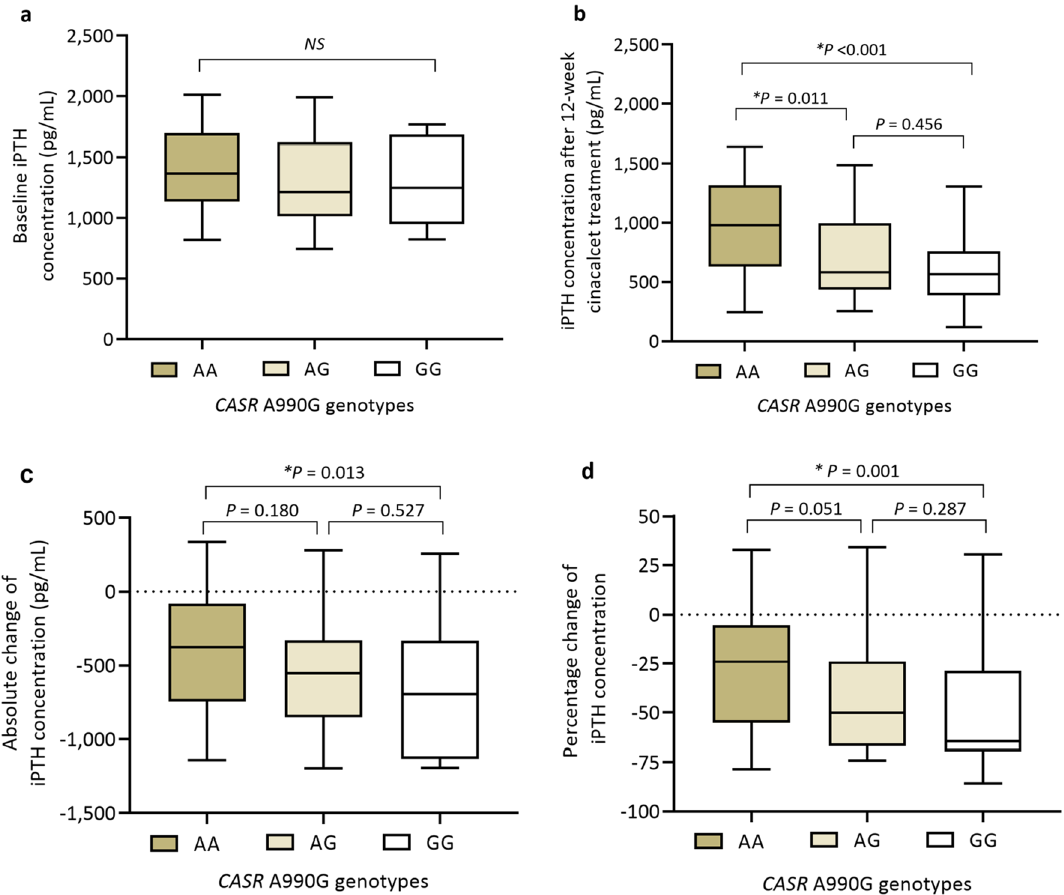
Figure 2. Box plots of intact parathyroid hormone (iPTH) concentrations before and after 12 weeks of cinacalcet treatment of 135 participants ( a ) Baseline iPTH data ( b ) iPTH concentration after 12 weeks of cinacalcet treatment ( c ) Absolute change of iPTH concentration from baseline to 12 weeks ( d ) Percentage change of iPTH concentration from baseline to 12 weeks. In each box, the top, the middle line, and the bottom represent the 75th percentile, the median, and the 25th percentile, respectively. The whiskers show the maximum and the minimum. The data were compared by Kruskal–Wallis test among three genotypes and by Mann–Whitney test between two genotypes. *p < 0.05 was considered statistically